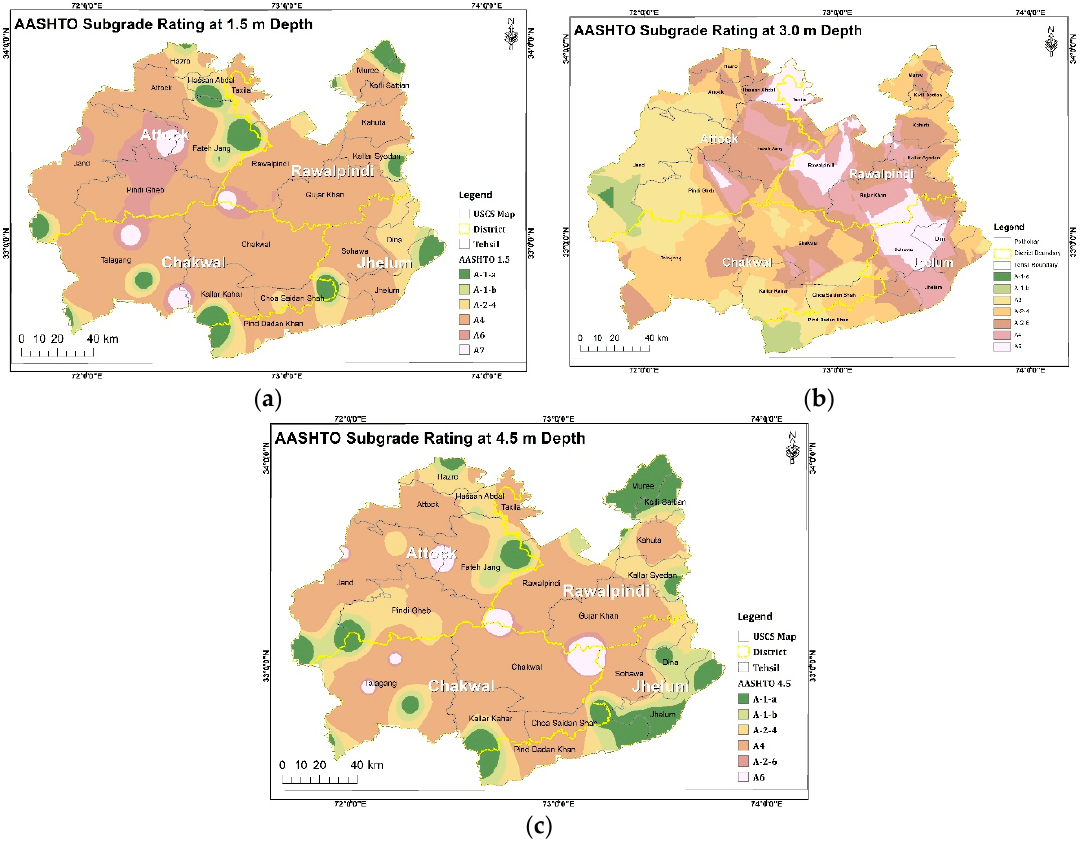
Figure 6. ( a ) AASHTO Subgrade Rating at 1.5-m Depth; ( b ) AASHTO Subgrade Rating at 3.0-m Depth; ( c ) AASHTO Subgrade Rating at 4.5-m Depth.